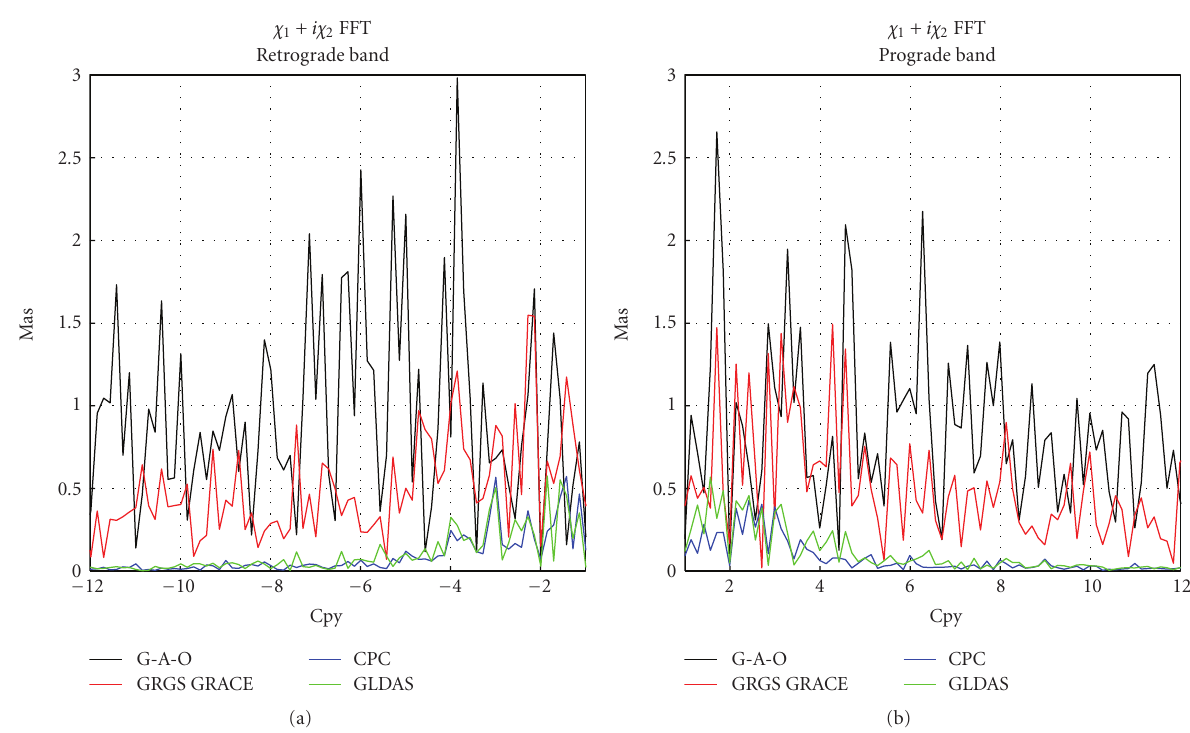
Figure 7: Intraseasonal variations spectrum computed from the geodetic residuals (G-A-O), GRACE, CPC, and GLDAS-based excitations. Data sets are interpolated with an uniform sampling of 10-days. GRACE observations provide more power than hydrological models, especially in the prograde and retrograde bands around the frequency of 3 cycles per